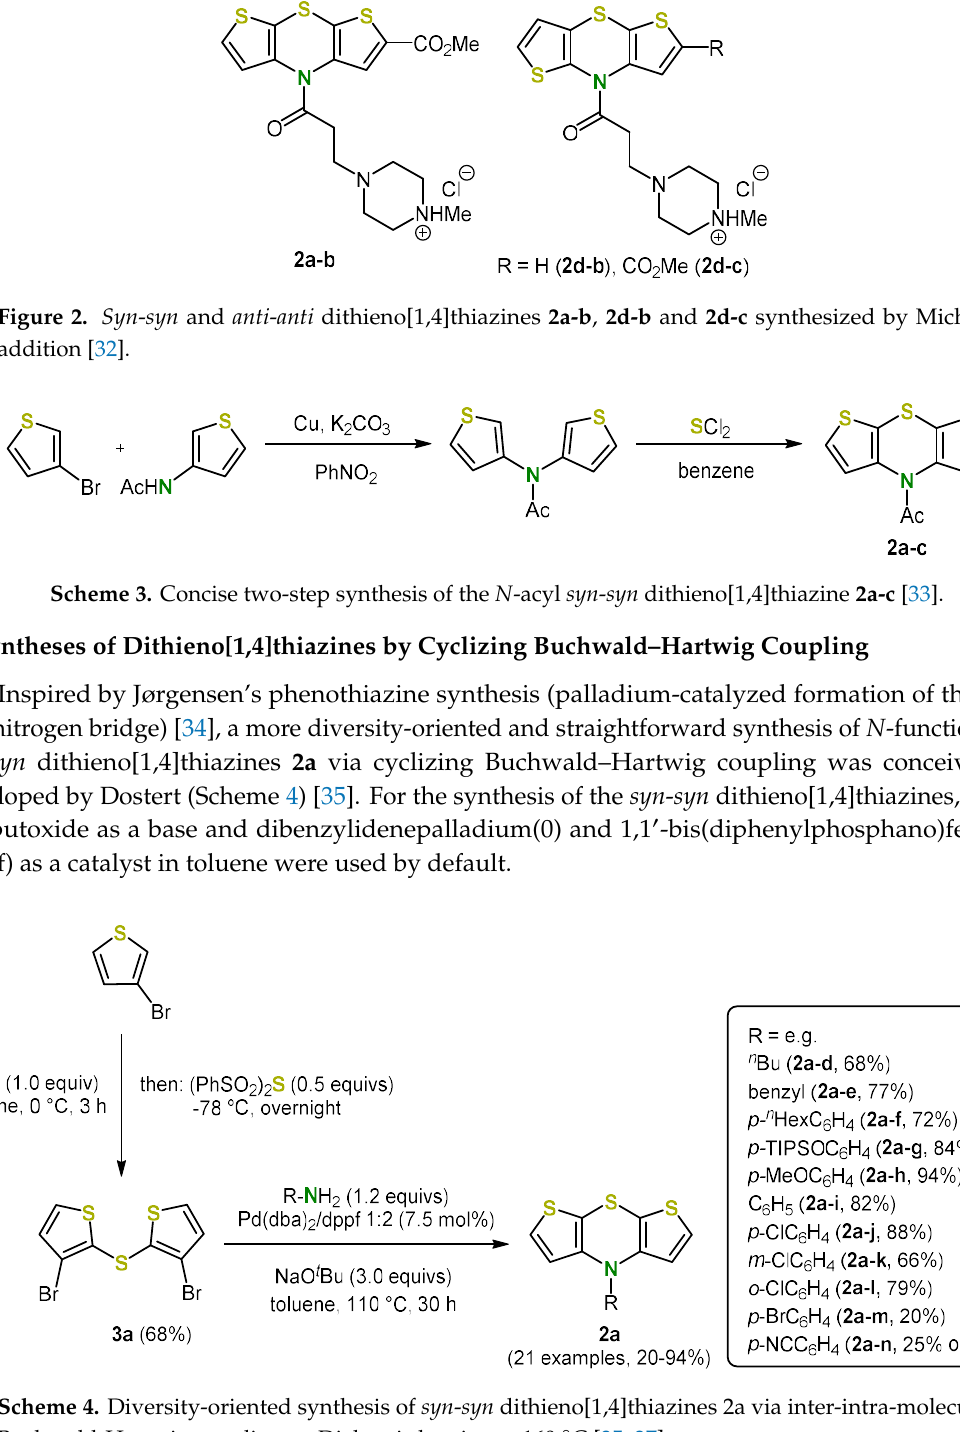
Figure 2. Syn - syn and anti - anti dithieno[1,4]thiazines 2a-b , 2d-b and 2d-c synthesized by Michael addition [32].